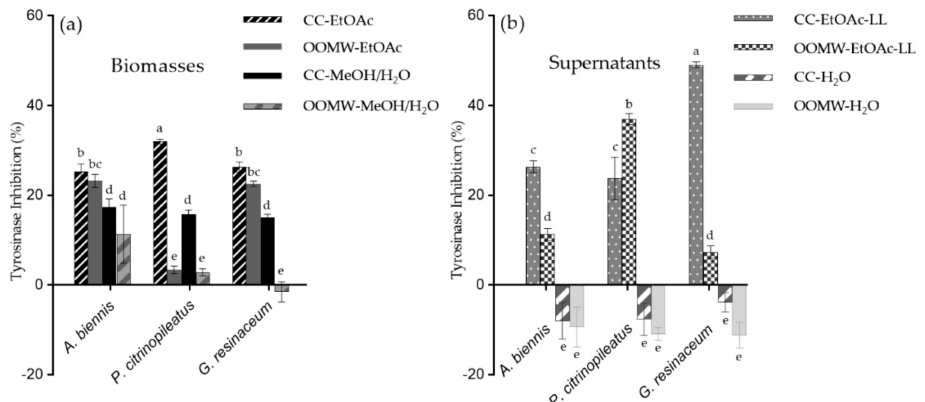
Figure 1. Tyrosinase inhibitory activity of fungal cultures (300 µ g mL − 1 ). ( a ) Biomasses; ( b ) Culture supernatants; Positive control: Kojic Acid (2 µ g/mL), inhibition% = 44.40 ± 1.37; inhibition% of non-inoculated growth media: CC-EtOAc-LL= 41.82 ± 1.44, OMWW-EtOAc-LL = − 16.59 ± 3.27, CC-H 2 O = − 5.05 ± 3.07, OMWW-H 2 O= − 7.91 ± 1.95. Experiments were performed in triplicate; Error bars indicate ± standard errors; ( p < 0.001, HSD Tukey